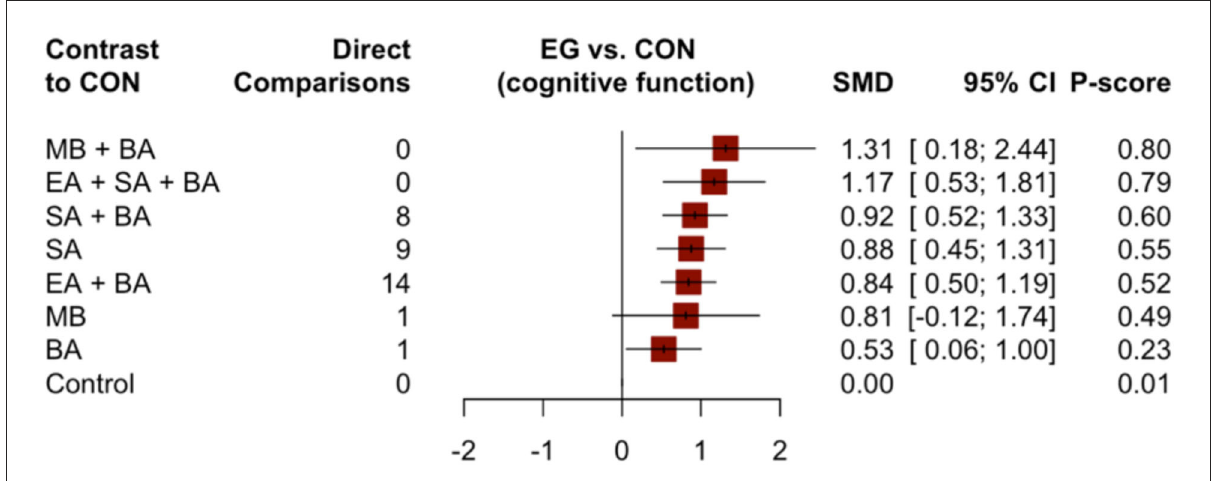
FIGURE4 Forest plot compared with the control group (cognitive